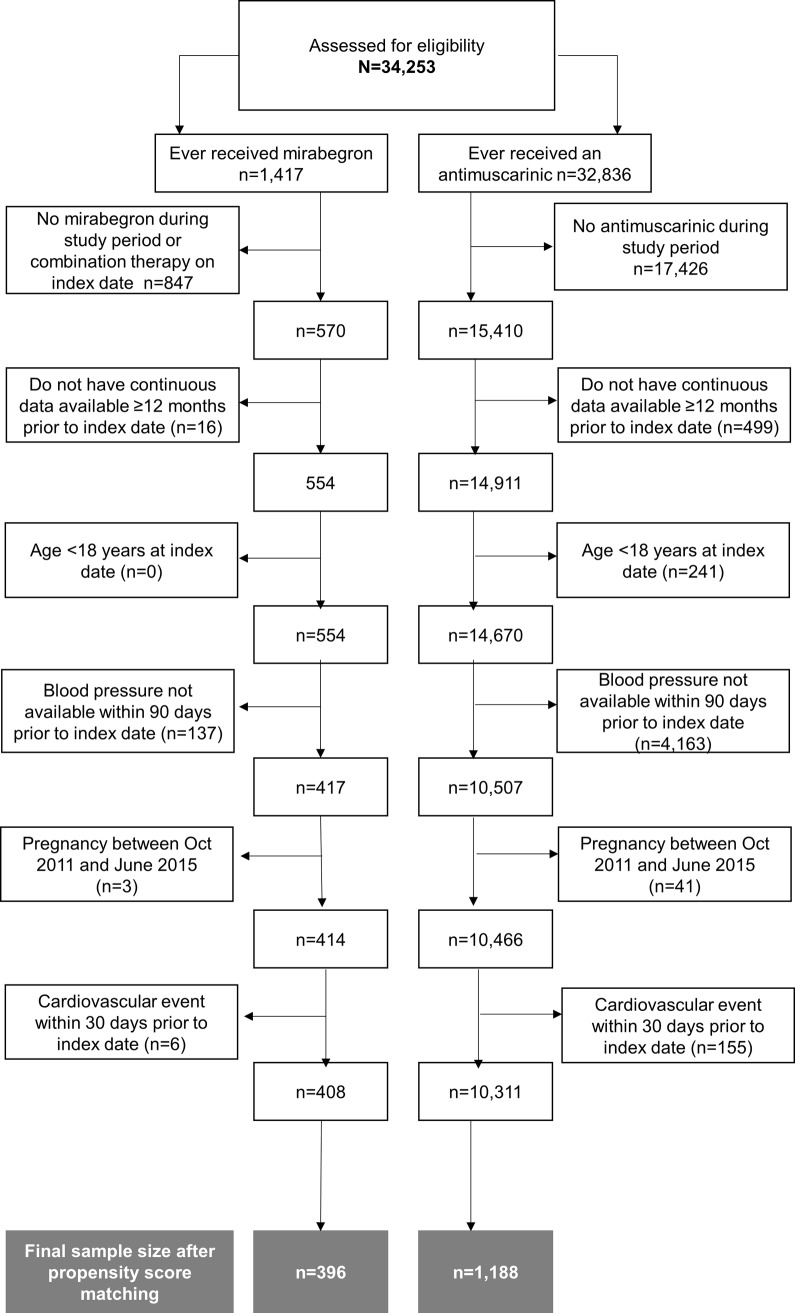
Cohort attrition.